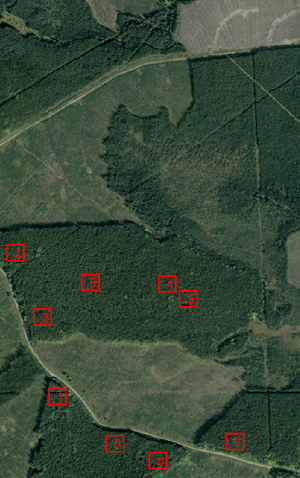
Figure 17. Location of ROIs. Table 1. TomoSAR- and LiDAR-derived tree height statistical descriptors.